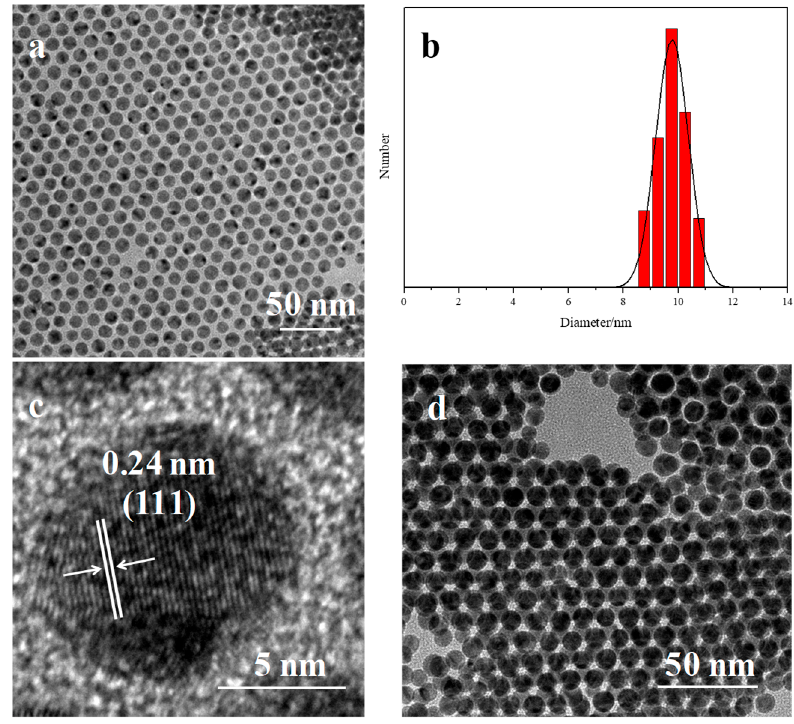
Figure 1. ( a , c , d ) TEM and high-resolution TEM images and ( b ) the corresponding particle size distributions of Au NPs obtained using toluene as solvent at 120 °C.